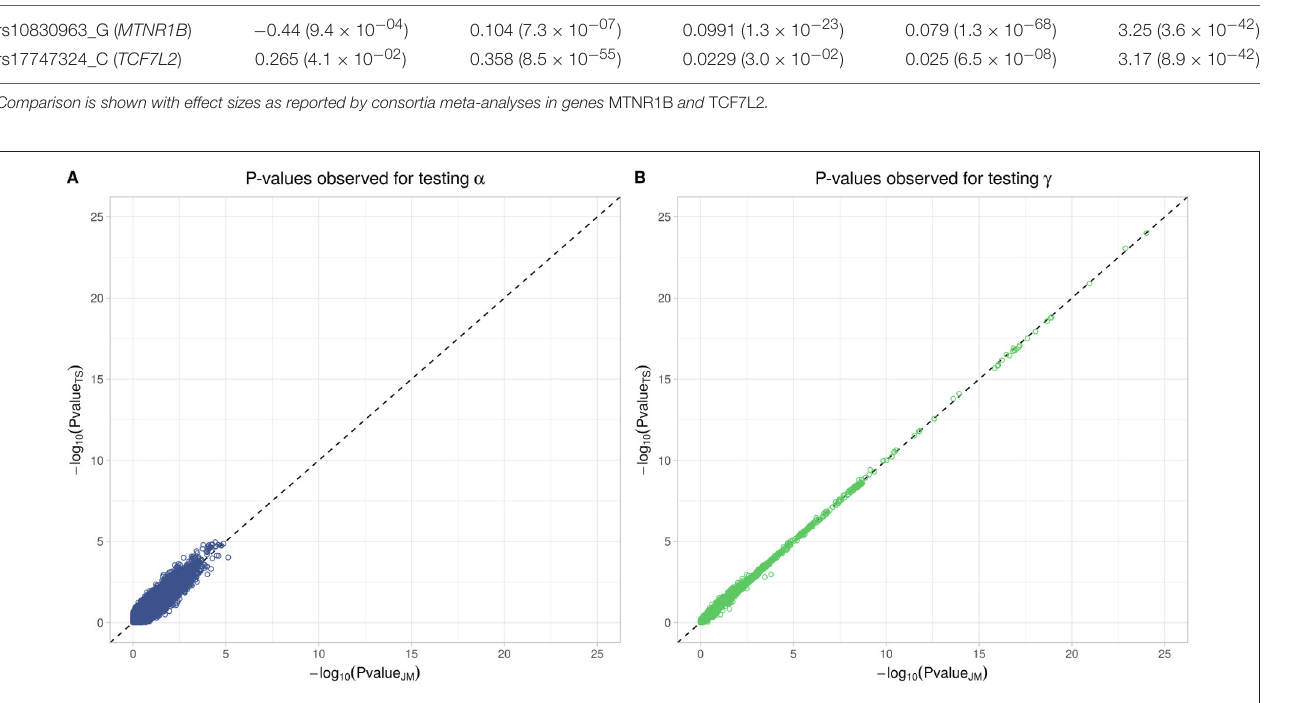
FIGURE 8 | Testing for α (SNP effect on onset of T2D) and γ (SNP effect on the trajectory of FPG) using Two-Step approach compared to Joint Model approach. On the x-axis, − log 10 ( p -value) from the Joint Model and on the y-axis the corresponding − log 10 ( p -value) from the approximate Two-Step approach. (A) Displays − log 10 ( p -value) for testing α parameter from Equation (4). (B) Displays − log 10 ( p -value) for testing γ parameter from Equation